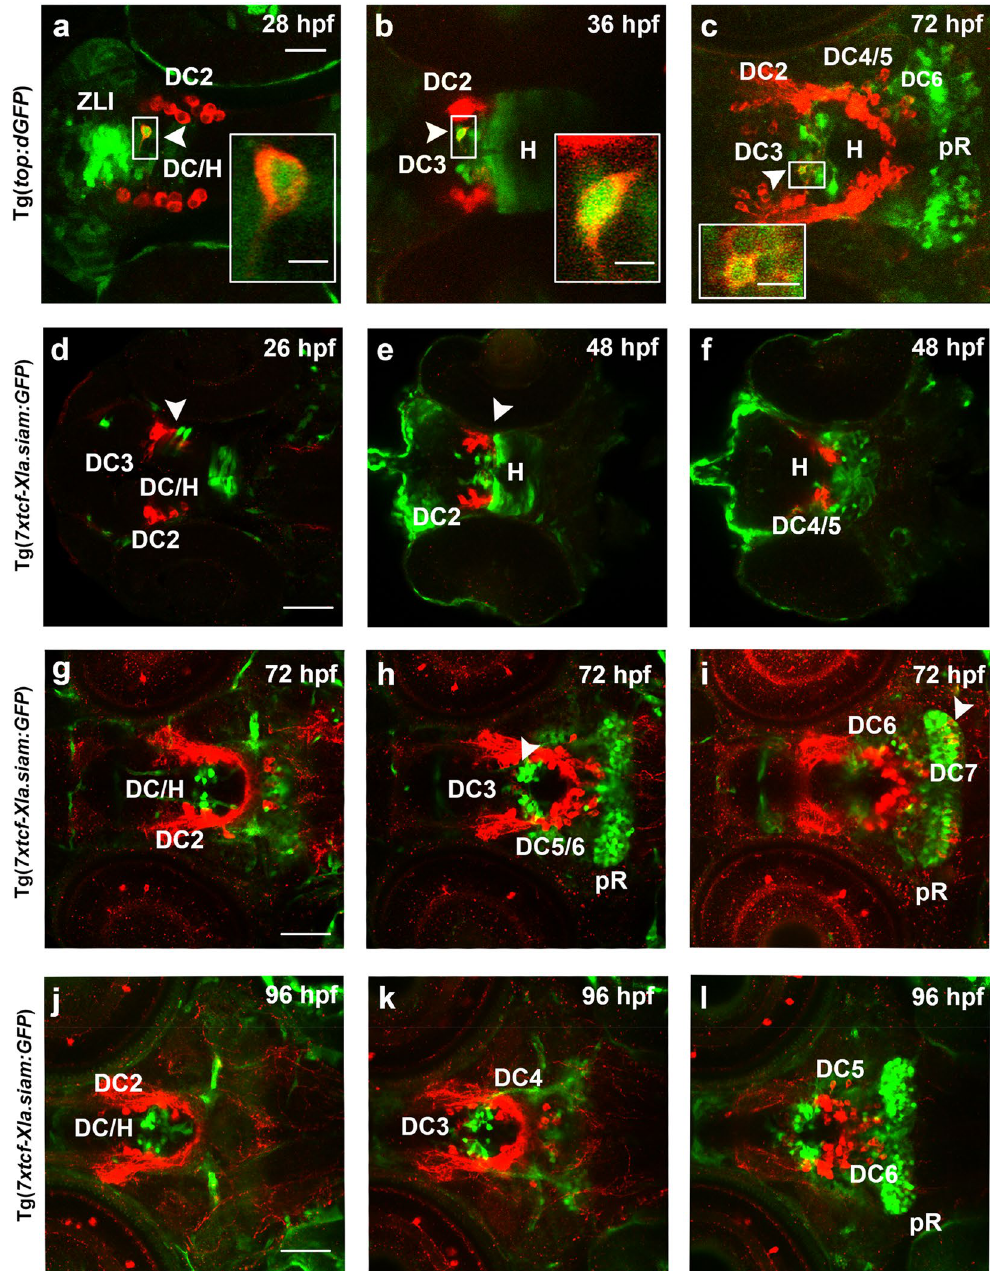
Figure 2. Activity domains of Wnt/β-catenin signaling in relation to TH-immunoreactive cells in the ventral diencephalon and hypothalamus. ( a – l ) Wnt/β-catenin-reporter Tg( top:dGFP ) ( a – c ) and Tg( 7xtcf-Xla.siam:GFP ) ( d – l ) zebrafish embryos were stained by double immunofluorescence for TH-immunoreactive cells (red) and GFP-immunoreactive cells (green) at indicated stages. Dorsal views of the ventral diencephalon/hypothalamus region. Confocal image stacks were recorded and images show 1.2 µm single optical sections of Z-stacks containing TH-immunoreactive cells. DA neuron groups DC2 and DC4 of the ventral diencephalon, DC3 of the medial hypothalamus and DC5 and DC6 of the hypothalamus are labeled. ( e , f ) Two optical sections of a single 48 hpf embryos at 33.02 µm distance from dorsal ( e ) to ventral ( f ). ( g – i ) Three optical section of single 72 hpf embryo at ( g – i ) 16.51 µm and ( i , j ) 11.43 µm distances, with the dorsalmost section shown in ( g ). ( j – l ) Three optical section of a single 96 hpf embryo at ( j – k ) 11.43 µm and ( k – l ) 13.47 µm distances, with the dorsalmost section shown in ( j ). ( d – l ) Z-stacks are included in Supplementary Information as Supplementary Video 4 ( g ), Supplementary Video 5 ( e , f ), Supplementary Video 6 ( g – i ) and Supplementary Video 7 ( j – l ). Inserts in ( a – c ) show higher magnifications of boxed areas in ( a – c ). Scale bar in ( a ) is 20 µm for ( a – c ) and in ( d , g , j ) is 50 µm for ( d – l ) Scale bars in inserts are 5 µm for ( a – c ). DC diencephalon, H hypothalamus, pR posterior recess, ZLI Zona limitans